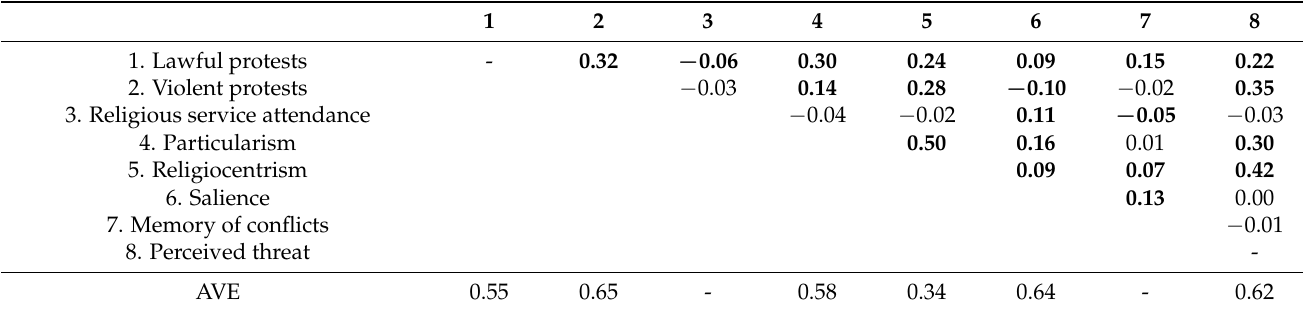
Table 2. Bivariate correlations and